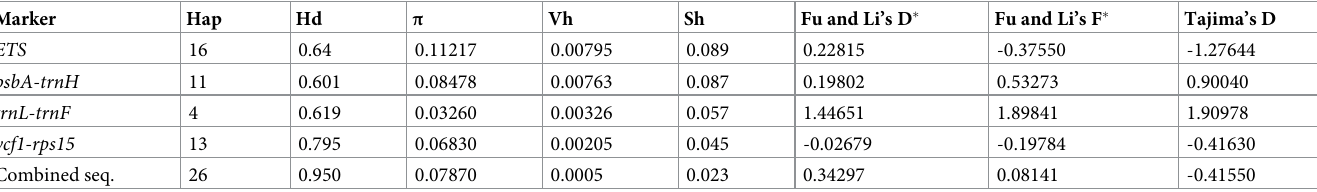
statistics for ETS were 0.22815 and -0.37550 respectively, and the Tajima’s D was -1.27644, not significant at the level of P > 0.10, indicating its conformity with the neutral evolution model; the Fu and Li’s D � and F � test statistics for the psbA-trnH were 0.19802 and 0.53273 respec- tively, and the Tajima’s D was 0.90040, not significant at the level of P > 0.10, conforming also with the neutral evolution model; the Fu and Li’s D � test statistic for the trnL-trnF was 1.44651, with significant difference at the level of P < 0.05, Fu and Li’s F � test statistic was 1.89841, showing a significant difference at the level of P < 0.02, and the Tajima’s D was 1.90978, not significant at the level of 0.10 > P > 0.05, suggesting its inconformity with the neu- tral evolution model; the Fu and Li’s D � and F � test statistics for the ycf1-rps15 were -0.02679 and -0.19784 respectively, and the Tajima’s D was -0.41630, not significant at the level of P > 0.10, in line with the neutral evolution model; the Fu and Li’s D � and F � test statistics of the combined sequence were 0.34297 and 0.08141respectively, and the Tajima’s D was -0.41550, insignificant at the level of P > 0.10, and conforms with the neutral evolution model (Table 4). The results suggested that the three intergenic spacers, ETS , psbA-trnH , ycf1-rps15 , and the combined sequence of the cultivated S . miltiorrhiza populations conform with the neutral evo- lution at the species level, while the trnL-trnF does not. Evolutionary relationship of the intergenic spacers Unrooted phylogenetic trees with a cut-off value of 50% for consensus based on the four inter- genic spacers ( ETS , psbA-trnH , trnL-trnF , and ycf1-rps15 ) of the 40 cultivated Danshen popula- tions were constructed. The phylogenetic trees based on ETS and psbA-trnH of S . miltiorrhiza were similarly shown a two-clade structure: for ETS , 28 populations clustered as one, and the Table 4. Nucleotide diversity of the intergenic spacers of the cultivated S . miltiorrhiza populations.